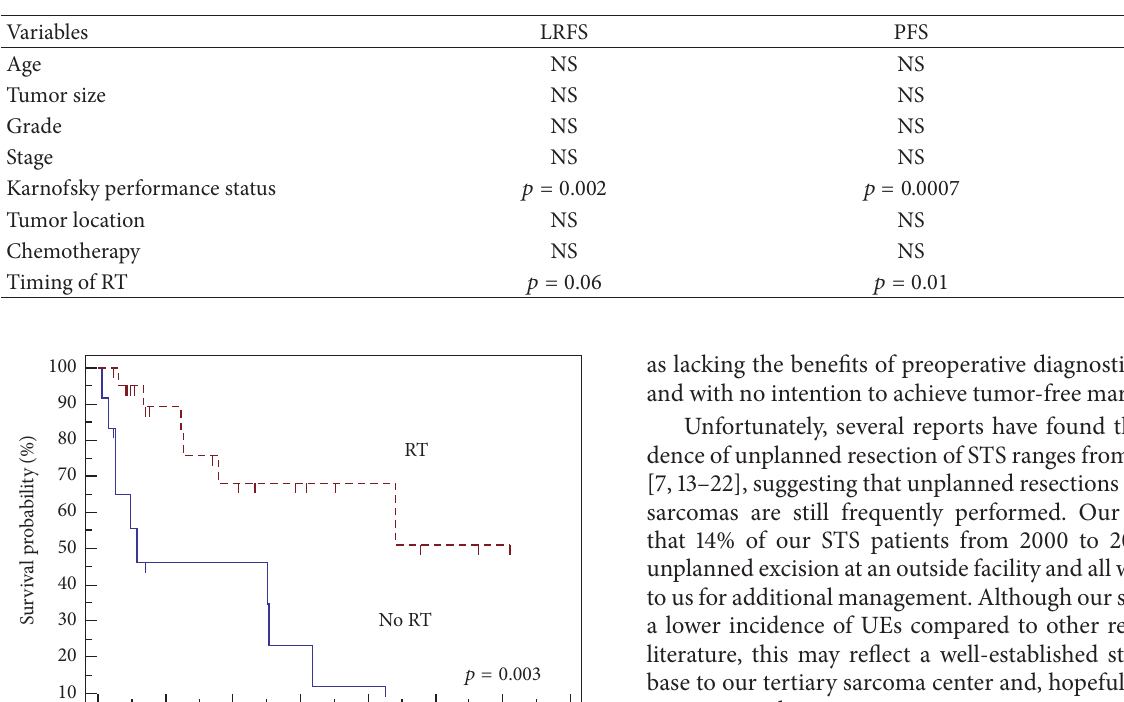
Table 3: Univariate analysis for local recurrence-free, progression-free, and overall survival (NS: not significant).